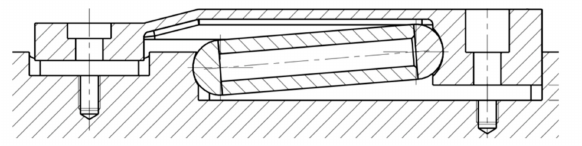
Figure 8. Proposed solution for